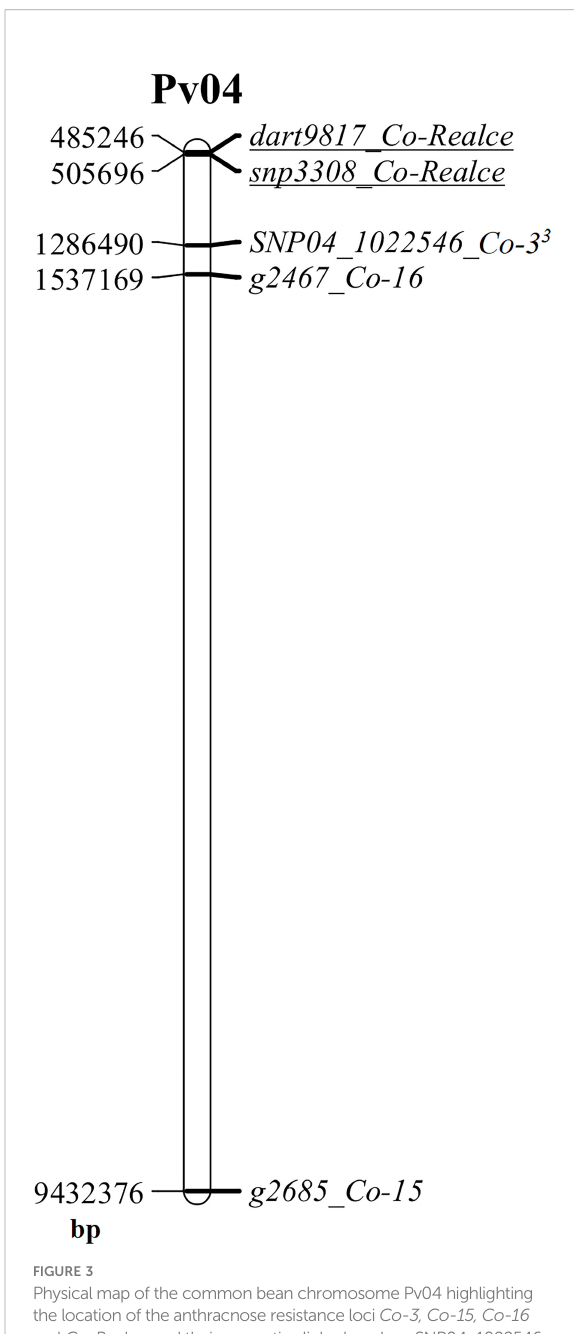
FIGURE 3 PhysicalmapofthecommonbeanchromosomePv04 highlighting thelocationof theanthracnoseresistanceloci Co-3, Co-15, Co-16 and Co-Realce , andtheirrespectivelinkedmarkers SNP04_1022546 ( Co-3 3 ),g2685( Co-15 ),g2467( Co-16 ),dart9817andsnp3308 ( Co- Realce ).Thisphysical mapwasbuiltusingthephysical positionof markersatthereferencegenome of Phaseolusvulgaris v2.1,available atwww.phytozome.net(Paulinoetal.,2022),usingthesoftware MapChart (Voorrips, 2002).